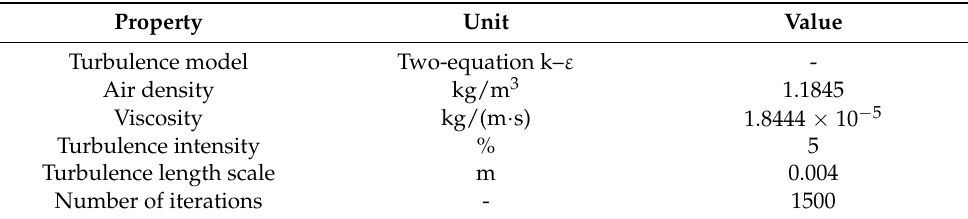
Table 2. Specific of fluid flow